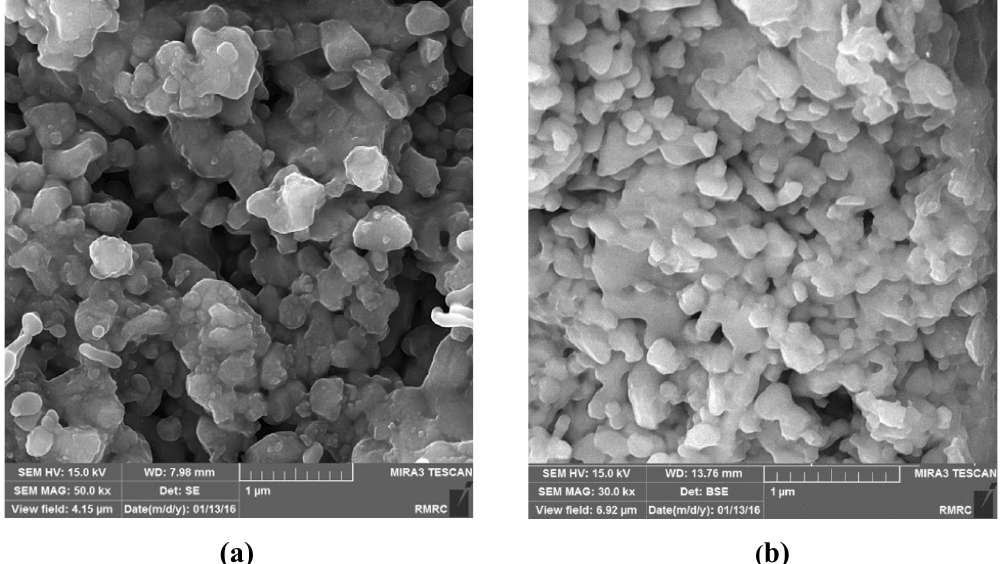
Fig. 3: FE-SEM images of alumina support membrane: (a) top surface image, (b) cross-section image.